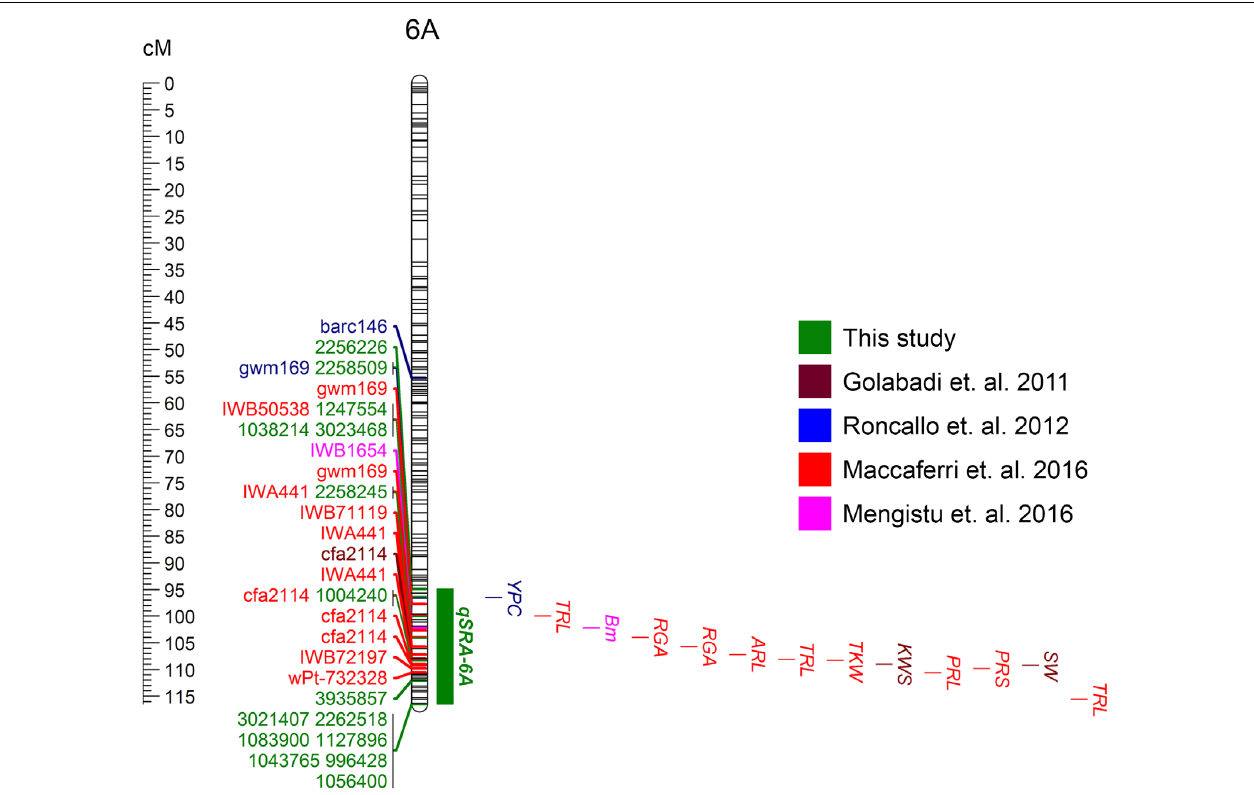
FIGURE 5 | Major QTL for seminal root angle ( qSRA-6A ) positioned on the Svevo durum physical map (Mbp), along with QTL reported in previous mapping studies including root system architecture traits (TRL, total root length; RGA, root growth angle; ARL, average root length; TRL, total root length; PRL, primary root length; PRS, primary root surface), yield component traits (Bm, biomass; TKW, thousand kernel weight; KWS, grain yield per spike; SW, spike dry matter) and a quality trait (YPC, yellow pigment